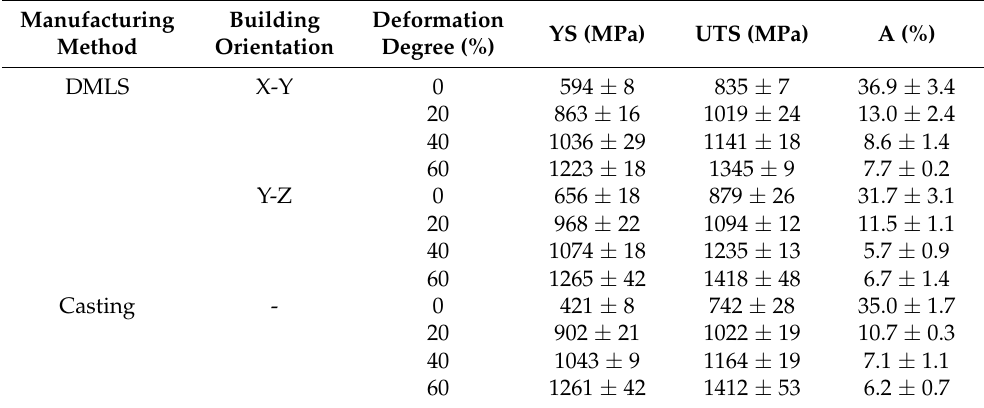
Table 3. Mechanical properties of DMLS and as-cast Haynes 282 after plastic